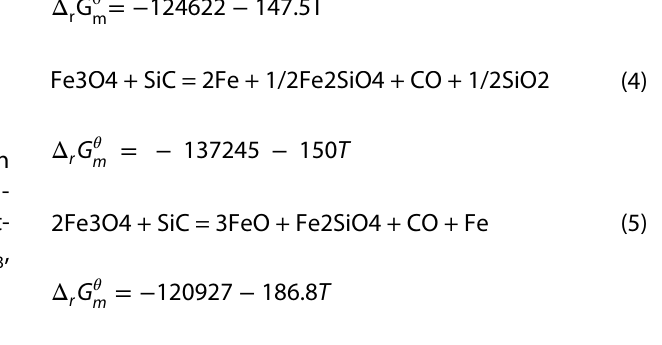
Fig.1 Composition of phase at equilibrium (a) Change in mass fraction of substances except phosphorus phase (b) change in mass fraction of phosphorus phase(where the temperature is below 1 200 ℃ for P , higher 2 than 1 200 ℃ for P 4